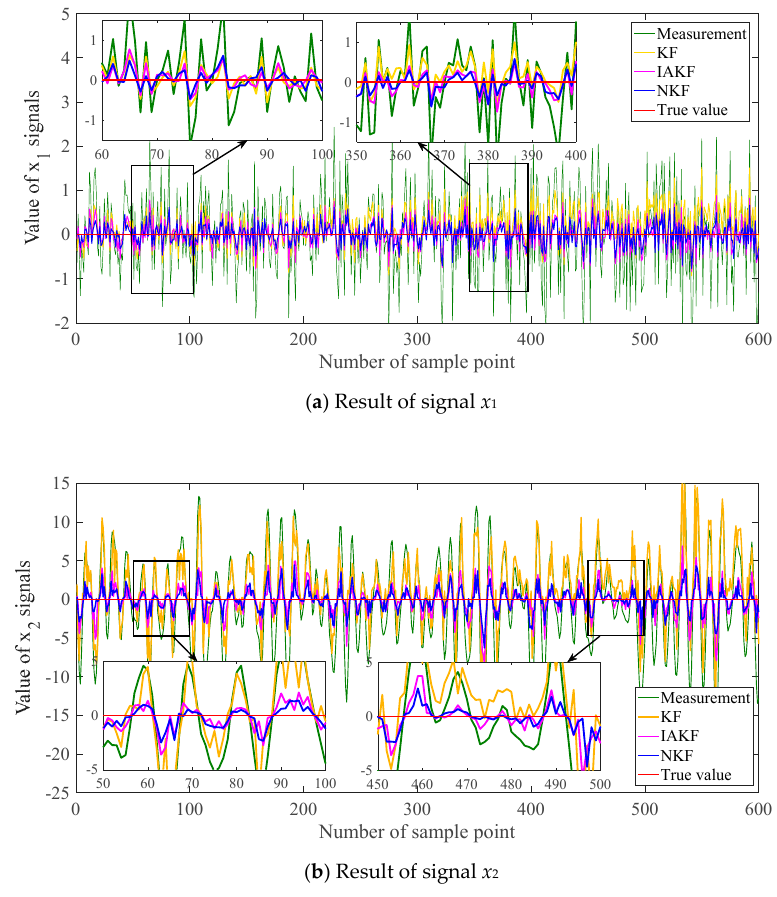
Figure 7. Filtering results of simulation signals.